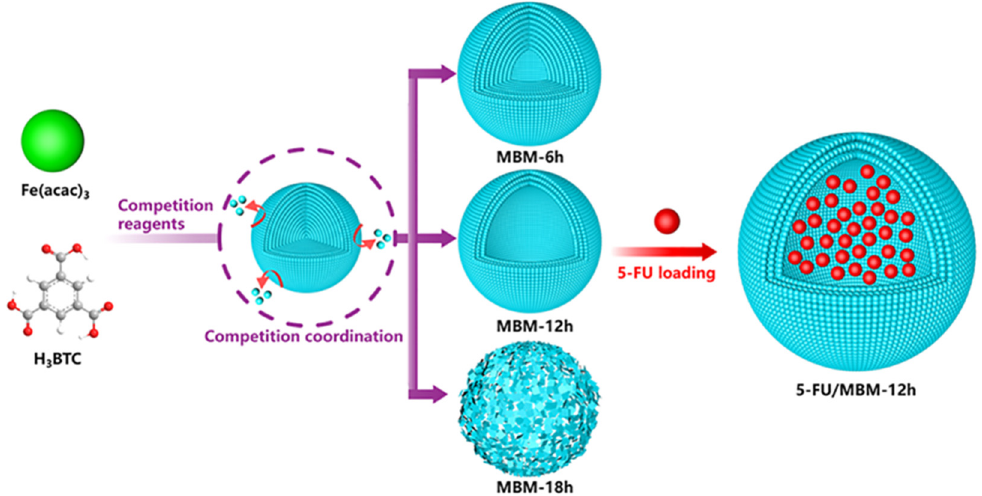
Figure 30. Schematic for synthesizing 5-FU/MBM-12 h microcapsules and MBM microcapsules with various reaction times (reproduced with permission of the American Chemical Society from ref. [113]).